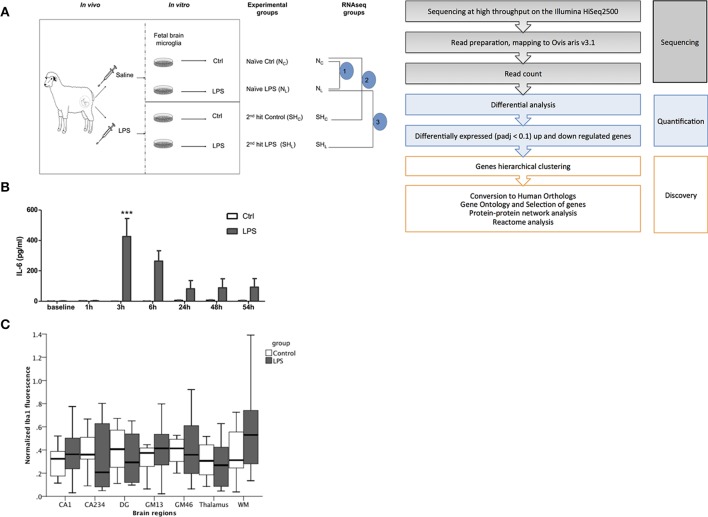
Fetal sheep in vivo LPS exposure causes a systemic inflammation. (A) Experimental design. In vivo, in vitro and RNAseq experiments are illustrated. In vivo study, Control (saline) and LPS; in vitro study, cultured cells derived from in vivo Control animal, named as Naïve, whereas cells derived from LPS-exposed animal named as 2nd hit (second hit, SH), there are four experimental groups: naïve Control (NC), naïve LPS (NL), 2nd hit control (SHC), and 2nd hit LPS (SHL), respectively. For RNAseq data comparisons, we first compared pair 1 (n = 6) Control (NC) vs. LPS-exposed naïve microglia (NL); then pair 2 (n = 4) naïve control (NC) vs. 2nd hit Control (SHC); and finally pair 3 (n = 4) naïve LPS-exposed microglia (NL) vs. 2nd hit LPS-exposed microglia (SHL). (B) IL-6 levels peaked at 3 h in fetal sheep plasma following LPS administration in vivo (***P < 0.001). In vivo Control group, n = 9, in vivo LPS group, n = 12. Blood samples were collected in heparinized syringe from fetal arterial catheter, plasma was obtained by centrifugation. A sheep specific IL-6 ELISA was performed to measure the cytokine levels. (C) No evidence of Iba1+ fetal brain microglia inflammatory response to LPS exposure in vivo. Normalized Iba1 + signal (microglia) fluorescence in six randomly chosen high power fields per brain region is shown in hippocampus [CA1, CA234, and dentate gyrus (DG) subregions], cortical gray matter (GM) layers GM13, GM46, white matter (WM), and thalamus. GEE model for prediction of Iba1+ normalized signal intensity: group main effect p = 0.62; brain region main effect p < 0.001; brain region*group interaction p = 0.13.